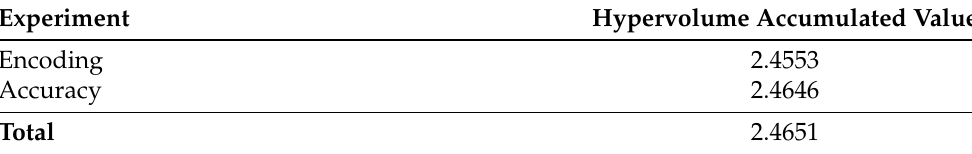
Table 16. Maximum accumulated Hypervolume